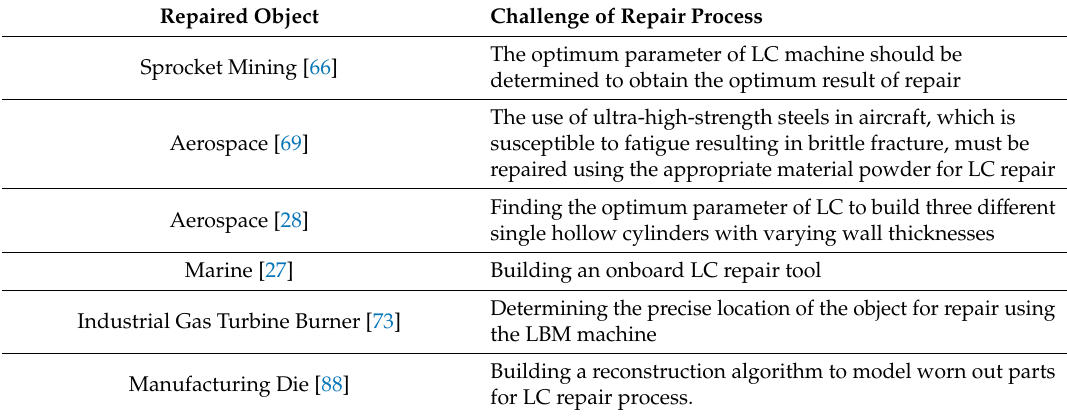
Table 9. Challenges in AM reparation from object design and process systems